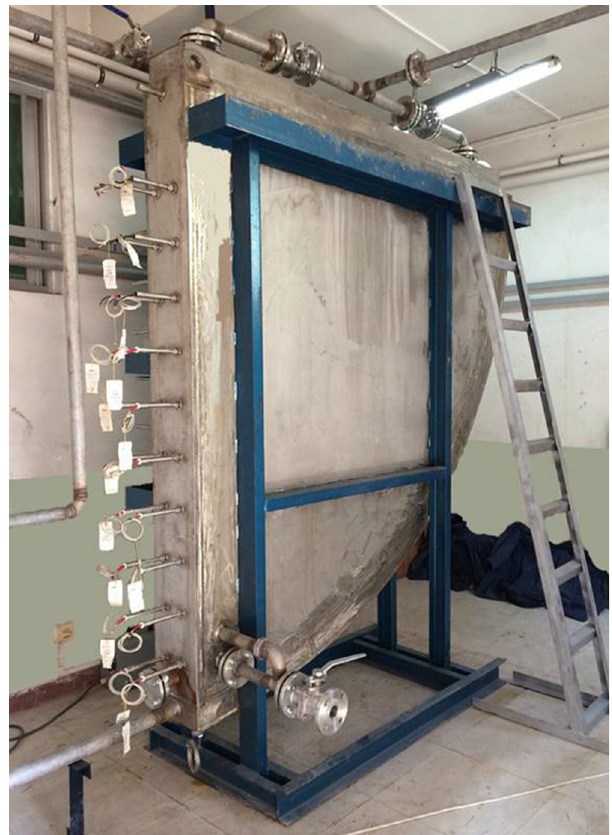
Fig. 2. COPRA test facility in Xi ’ an Jiatong University to study melt behaviour in the RPV lower